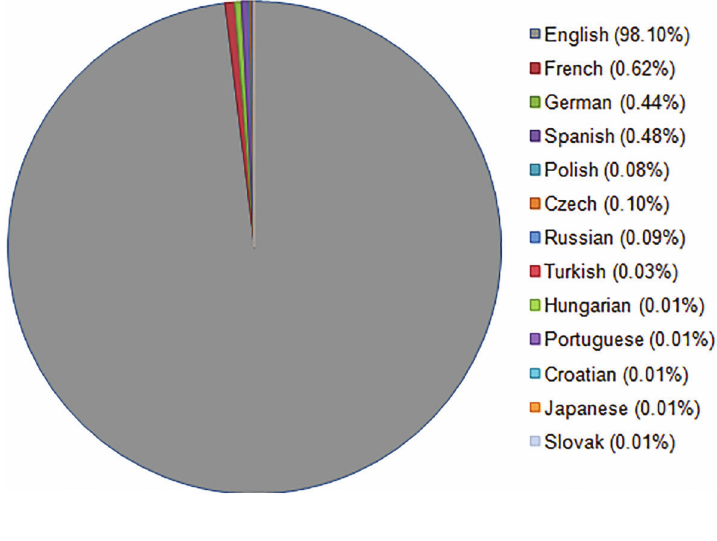
Figure 2. Graph showing the languages that have been used in publications about Huntington disease.